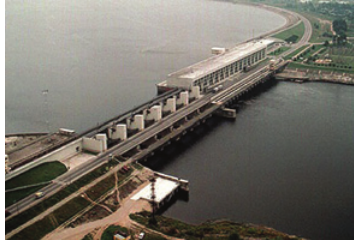
fig. 7. Bridge over the Daugava River near the hydro power